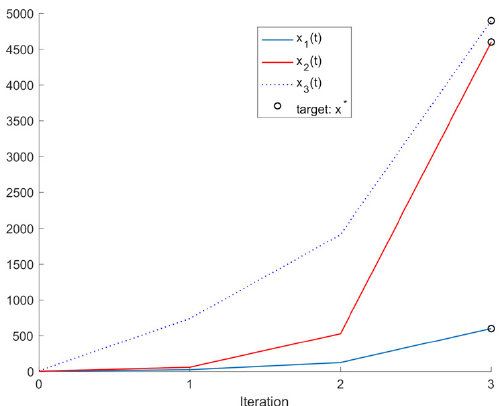
Figure 5. Evolution of stocks vector x t in Example 3.